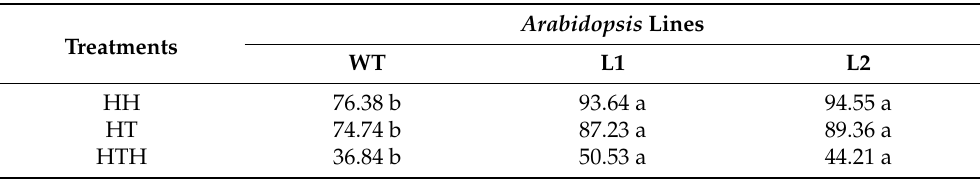
Table 2. Viability of seeds (%) harvested from the GmATX1 -overexpression Arabidopsis lines (L1 and L2) and WT after 2 d of different